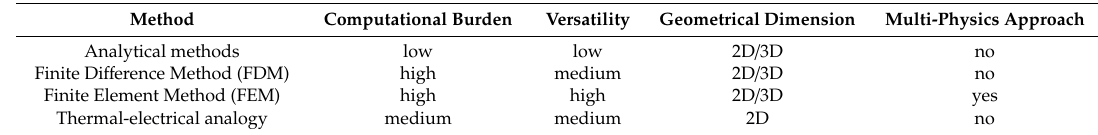
Table 3. Characteristics of the considered